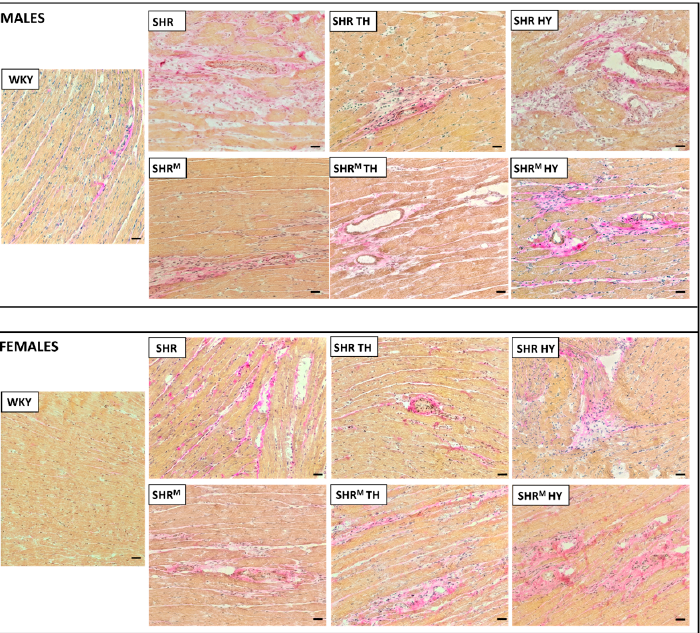
Figure 2. Van Gieson staining shows the collagen deposition (pink) of various degrees in all SHR groups with massive patchy fibrosis in hypothyroid rats. WKY—Wistar Kyoto euthyroid control rats, SHR—wild type spontaneously hypertensive rats, TH—hyperthyroid rats, HY—hypothyroid rats and SHR M —hairless spontaneously hypertensive rats, n = 5 per group. Scale bar represents 200 μ m.